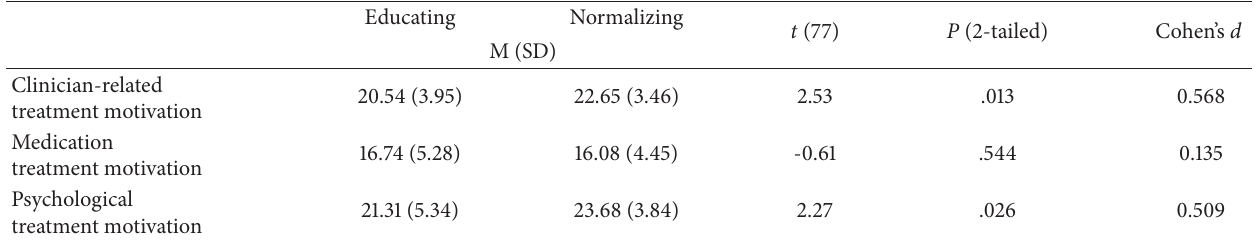
Table 1: Condition comparison of treatment motivation (independent t